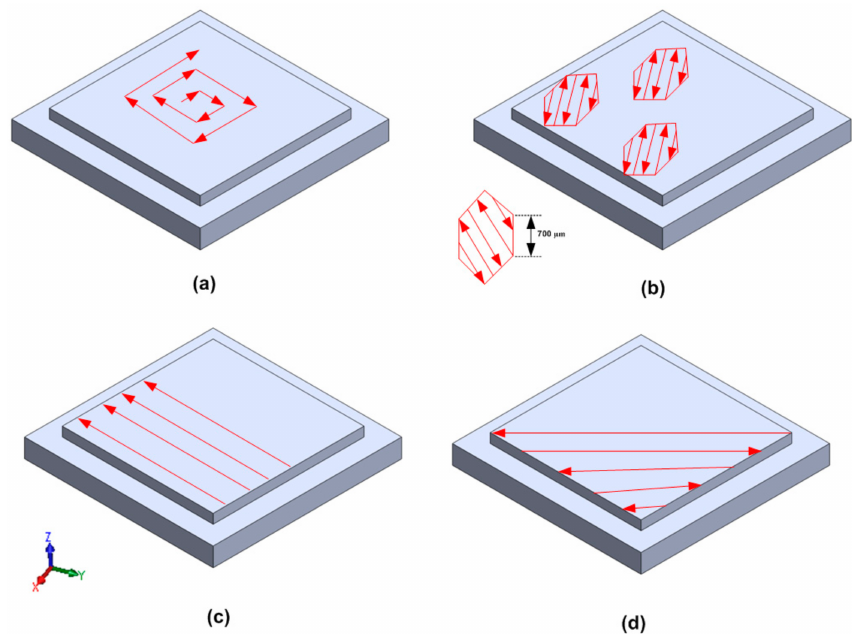
Figure 7. Scanning strategies used in this study: ( a ) Concentric in–out, ( b ) Hexagonal, ( c ) Linear and ( d ) Inclined